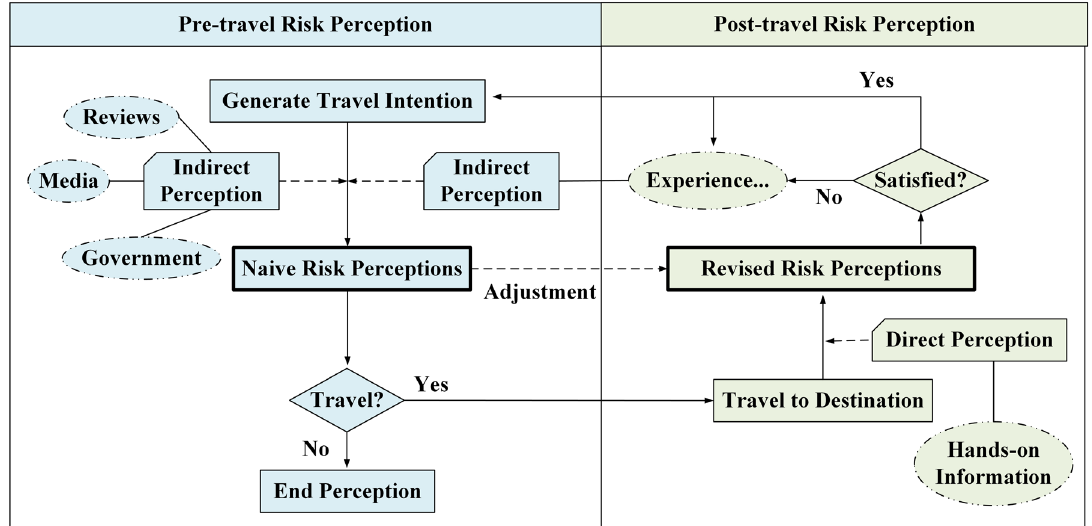
Fig. 1 The formation mechanism of destination risk perceptions before and after travel. A description of the differences in information acquisition ways and the of risk perception purpose before and after